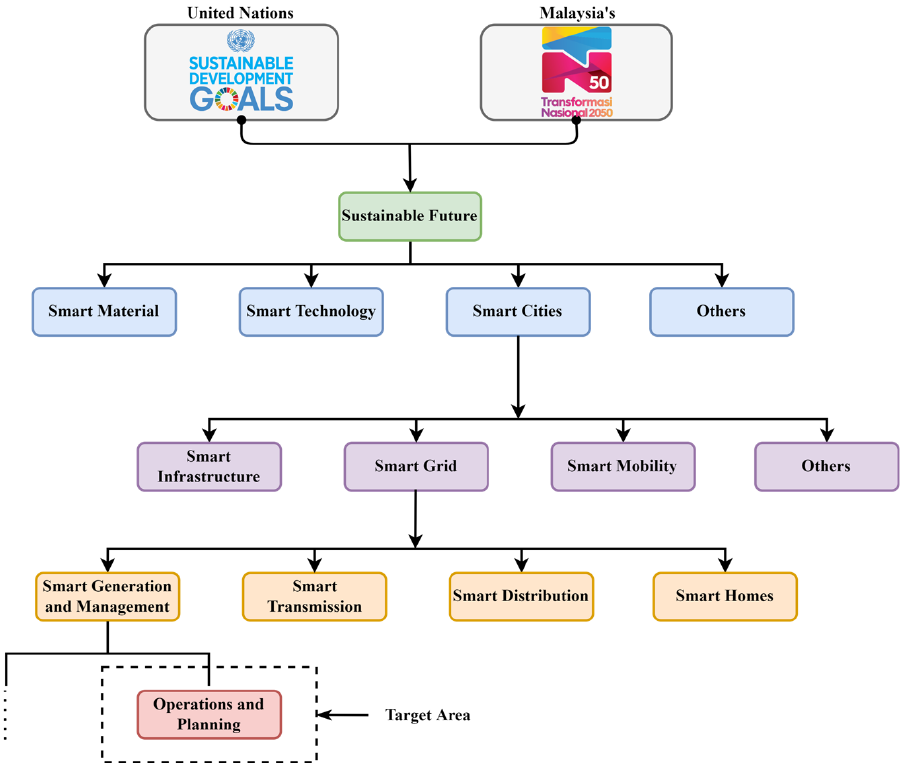
Figure 2. Hierarchical structure highlighting the importance of target area in smart cities and Smart grid for research impact on sustainable future.